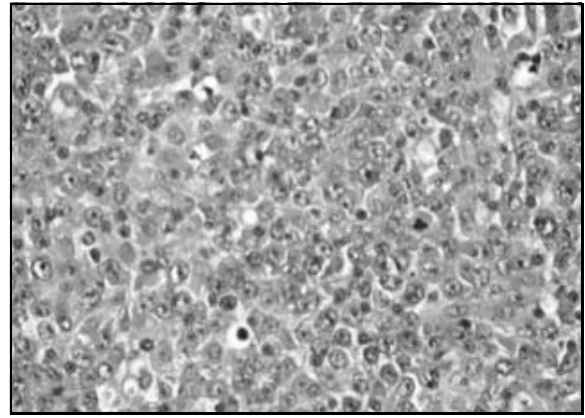
Figura 2 – Linfoma difuso de grandes células B (alto grau). Células predominantemente não-clivadas, com diferenciação centroblástica (HE